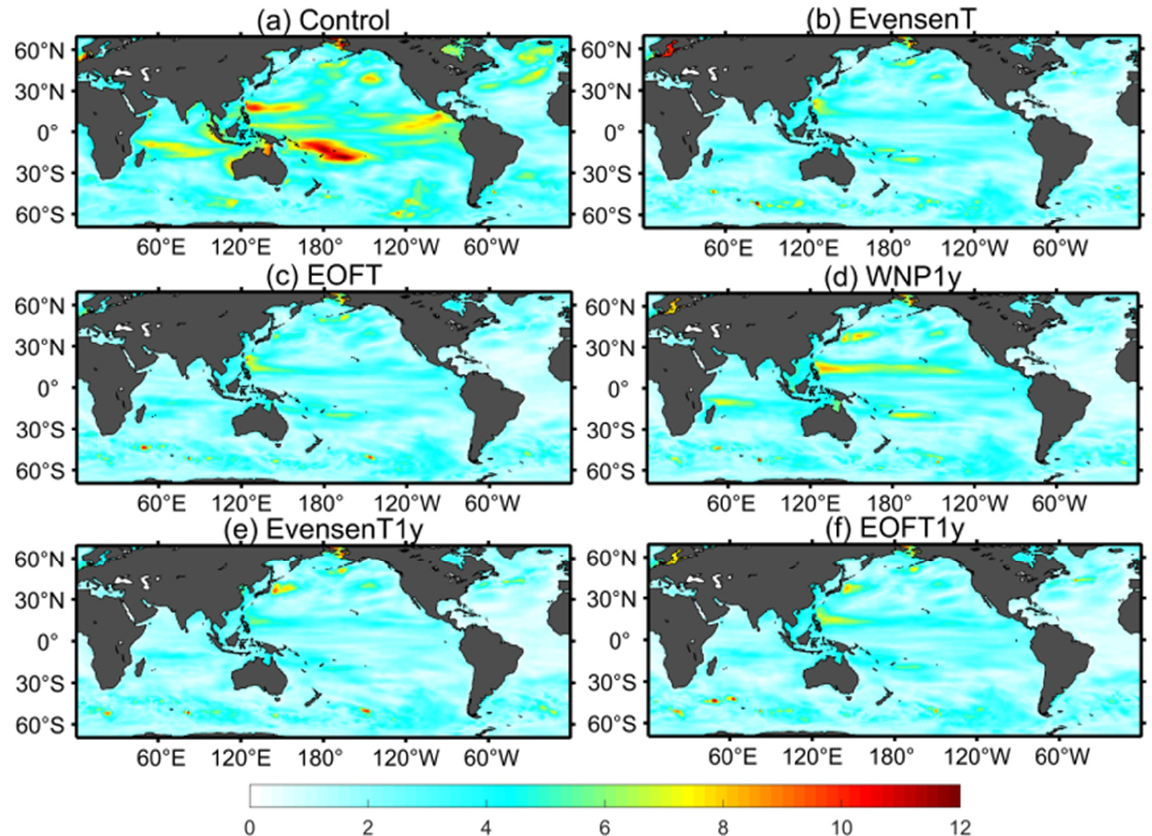
Figure 6 . The SSH RMSE for ( a ) the control, ( b ) the EvensenT experiment, ( c ) the EOFT experiment, ( d ) the WNP1y experiment, ( e ) the EvensenT1y experiment, ( f ) the EOFT1y experiment (unit: cm).